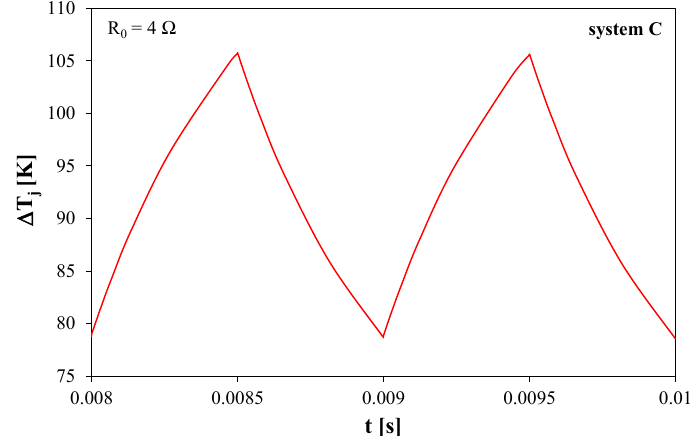
Figure 9. Waveform of the junction temperature at the steady state for the transistor operating in the